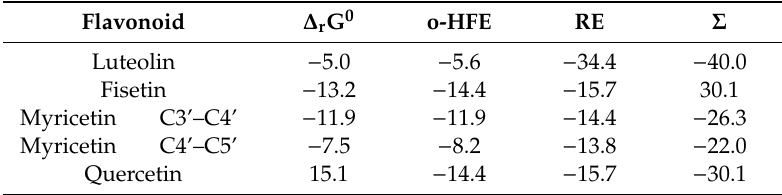
Table 9. o-Hydroquinone formation parameters [kcal / mol]. Flavonoid ∆ r G 0 o-HFE